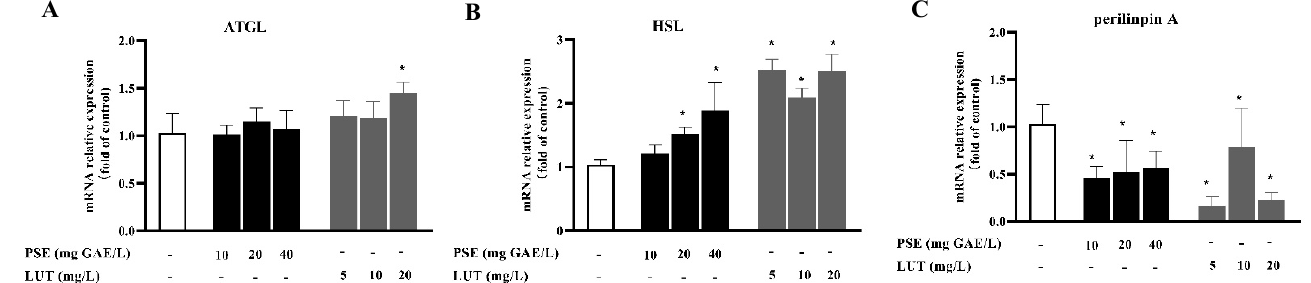
Figure 6. PSE and LUT modulated the expression of the mRNA involved in the lipolysis of the 3T3-L1 adipocytes. The relative mRNA expression of ( A ) ATGL, ( B ) HSL, and ( C ) Perilinpin A. The data are presented as the mean ± SD from three independent experiments. * Significant differences are indicated by p < 0.05.